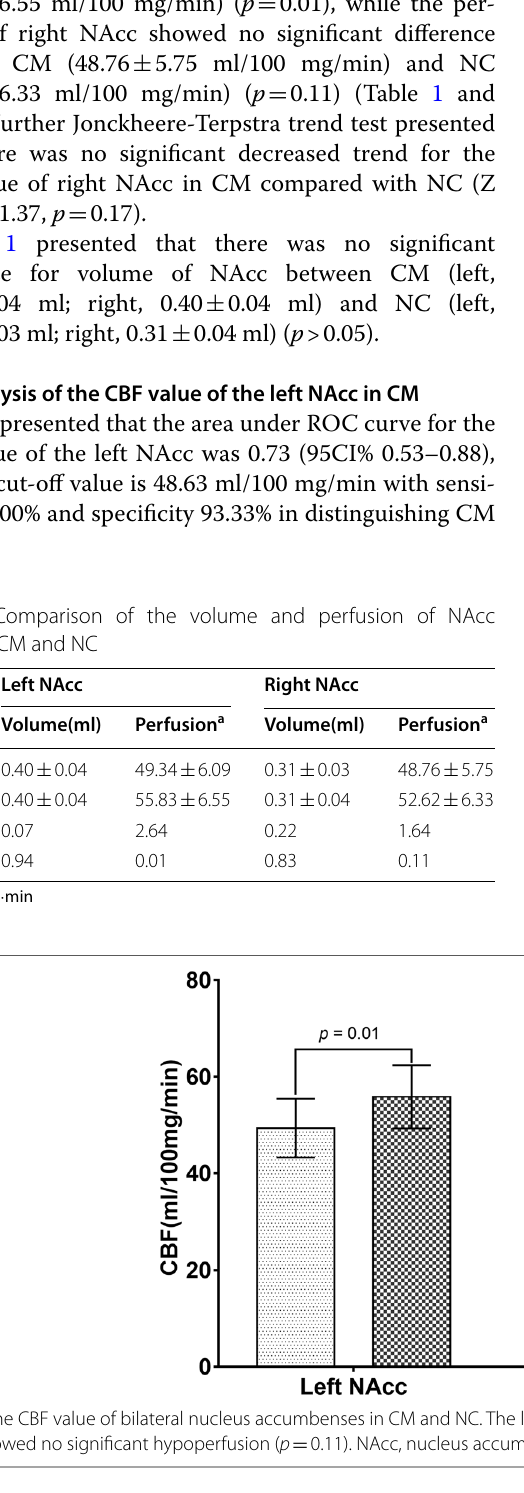
0.01), and the right =